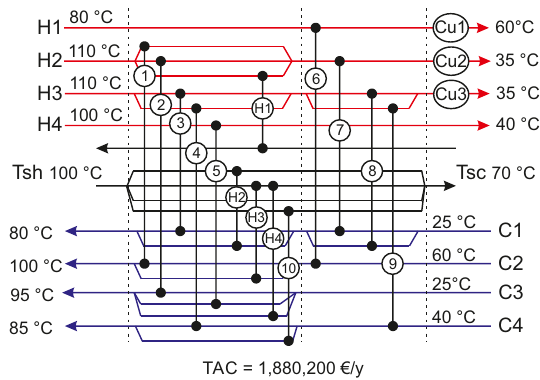
Figure 7. HEN obtained with HP and ST options case